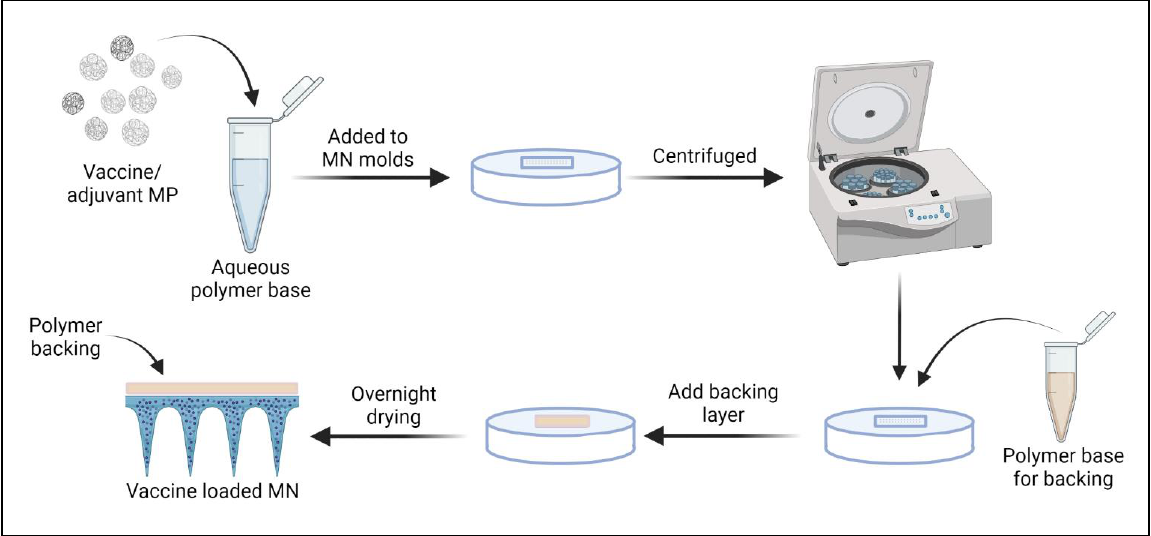
Figure 1. Preparation of vaccine-loaded MN : Vaccine/adjuvant MP were mixed with the polymer gel base, added to MN molds, and centrifuged to form the MNs. A backing layer of 10% HA was added, and the needles were allowed to dry overnight. The prepared MN were then removed and used for in vivo immunization. Image was created using Biorender.com (accessed on 3 August 2022).